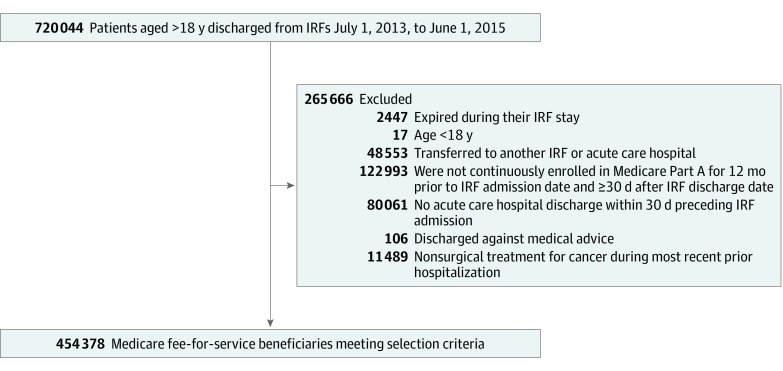
Cohort SelectionIRF indicates inpatient rehabilitation facility.